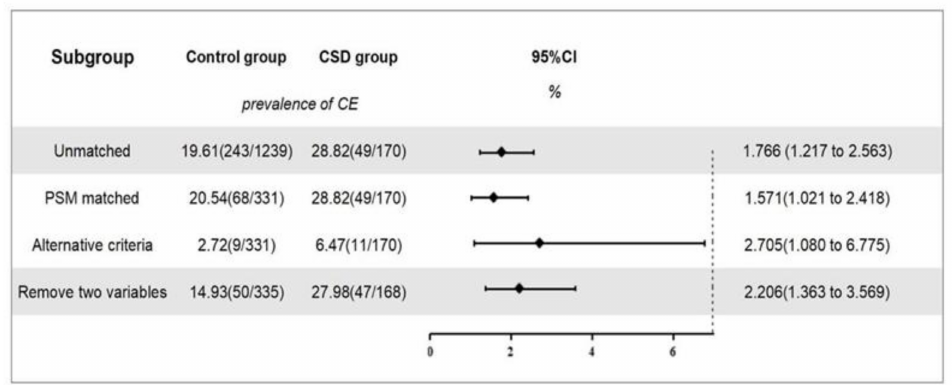
Figure 4. The prevalence of CE and sensitivity analyses. Note: Overview of the association between CSD and the prevalence of CE and sensitivity analysis. Alternative criteria: CE was diagnosed when a hysteroscopic-positive feature was present and accompanied by plasma cell count ≥ 5/HPF in endometrial biopsy. Remove two variables: age and BMI were removed as propensity score matching variables, and the logistic regression analysis was conducted